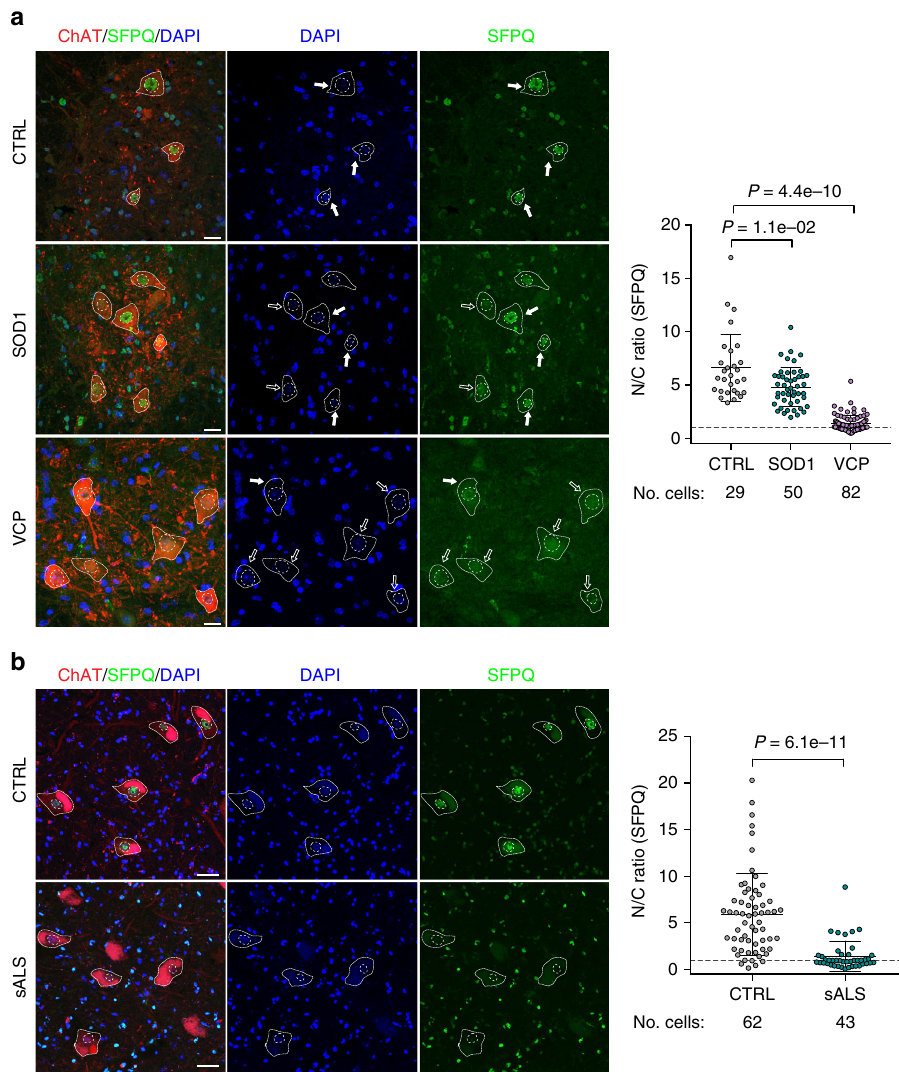
Fig. 6 SFPQ nuclear clearance is a molecular hallmark of genetic and sporadic ALS. a Analysis of the subcellular localisation of SFPQ in MNs in the ventral spinal cord of wild-type, VCP A232E and SOD1 G93A mice. MN cytoplasm was identi fi ed by ChAT staining, nuclei were counterstained with DAPI. Data shown is nuclear/cytoplasmic (N/C) ratio (mean ± s.d.) per cell from three wild-type, 4 SOD1 G93A and 3 VCP A232E mice. Scale bar: 20 μ m. P -values from one-sided Welch ’ s t -test. Cells from individual animals in each condition were pooled together after excluding individual mice effect by comparing full linear (disease and individual factor) with reduced linear (disease only) models using the Akaike Information Criterion. b Analysis of the subcellular localisation of SFPQ in MNs in the ventral spinal cord of healthy controls and patients with sporadic ALS (sALS). MN cytoplasm was identi fi ed by ChAT staining, nuclei were counterstained with DAPI. Only MNs with a visible nucleus were considered for the analysis. Scale bar 50 μ m. Data shown is N/C ratio (mean± s.d.)